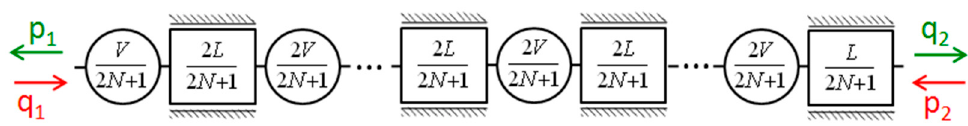
Figure 11. Example of 1D discretization of a hydraulic pipe [42].